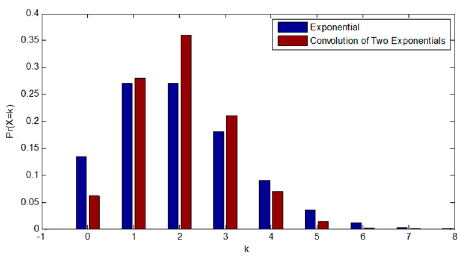
Figure 3. Plot of Poisson and convolution of two exponentials probabilities: β 1 = 4.2, β 2 = 4.85 (under dispersion).